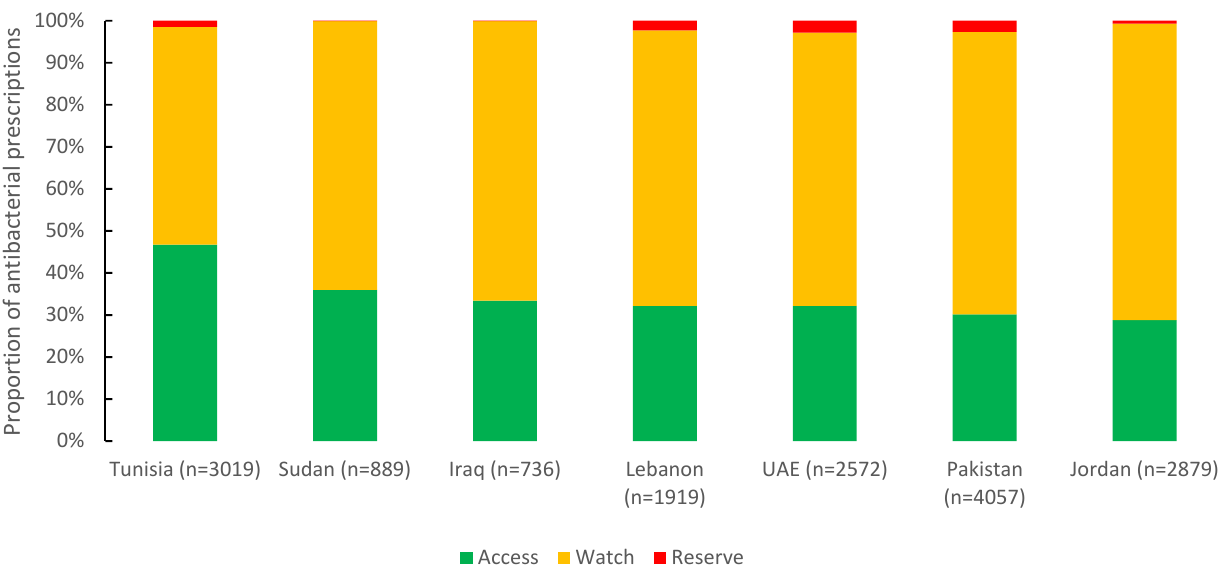
Reserve Figure 4. Distribution of prescribed antibacterial agents by AWaRe classification in seven countries in the Eastern Mediterranean Region, 2019 (n = 16,071).